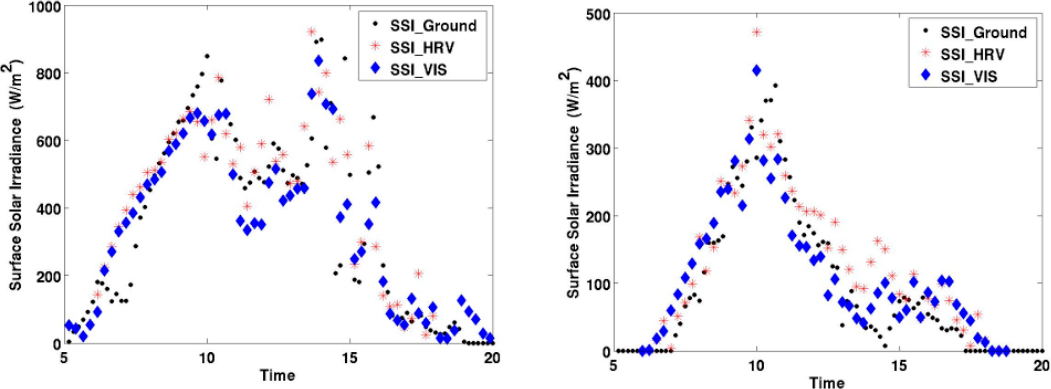
Figure 3. As in Figure 2, but for cloudy sky. ( Left column ): 15 June 2017 (Lat = 45.891499, Long = 10.188790). ( Right column ): 18 March 2018 (Lat = 45.187836, Long = 10.887401).